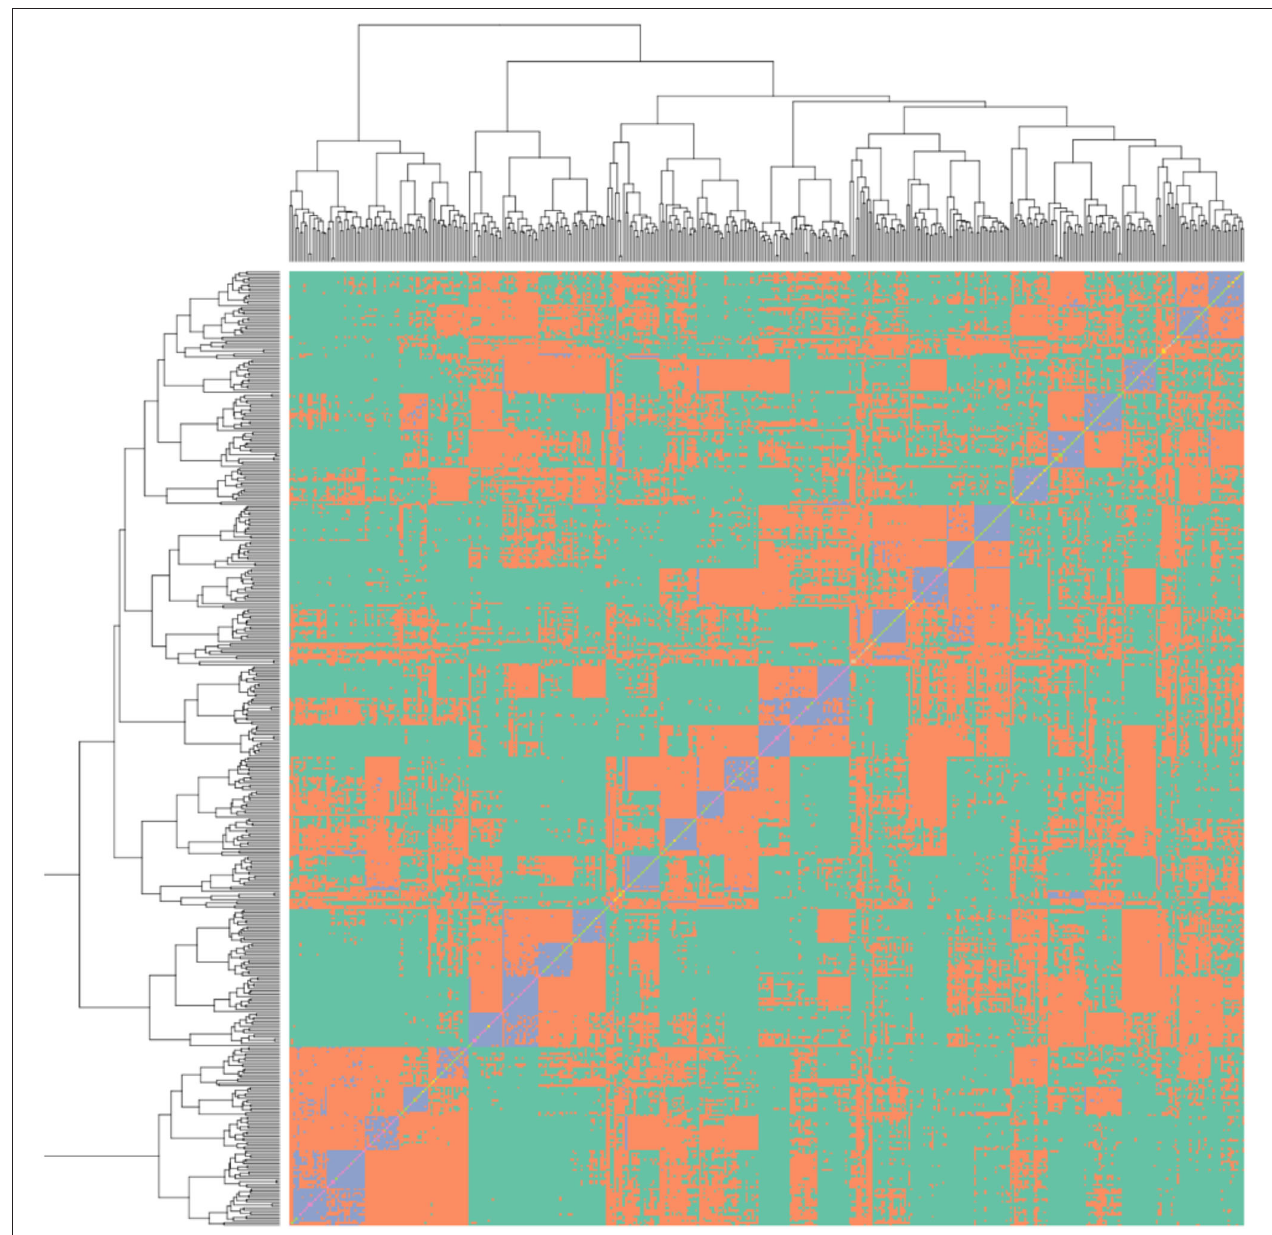
FIGURE 2 | Genetic relationship matrix for the strawberry multi-parental population, blue colouring represents the full sibling relationships, orange represents half-sibling relationships between individuals, green represents less than half-sibling relationships. The relationship within the 26 families can be observed in the blue squares along the